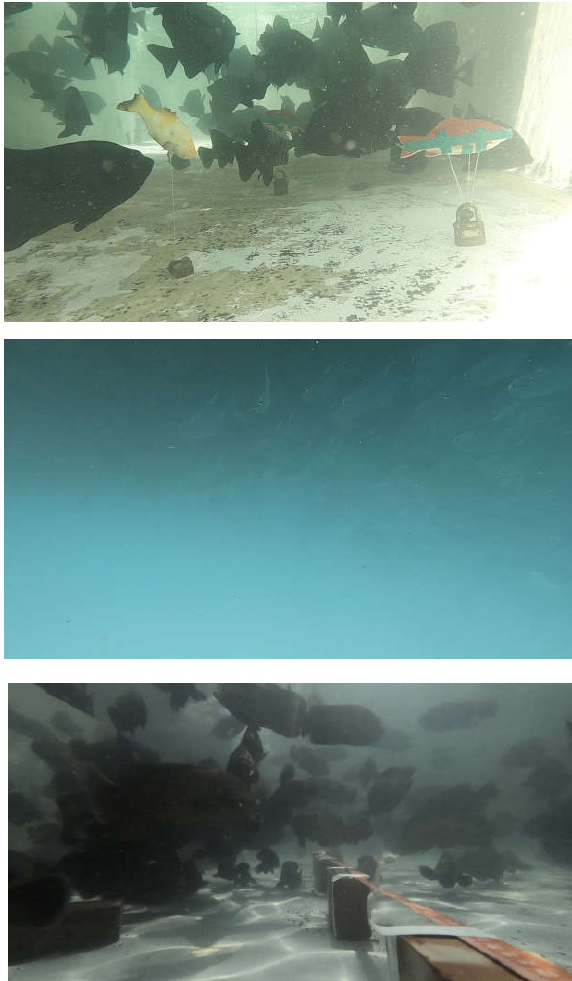
( b ) Figure 19. Fish classification results using ( a ) sonar and ( b ) stereo images. To ensure that our mechanism detects a correct object in both sonar and stereo im-